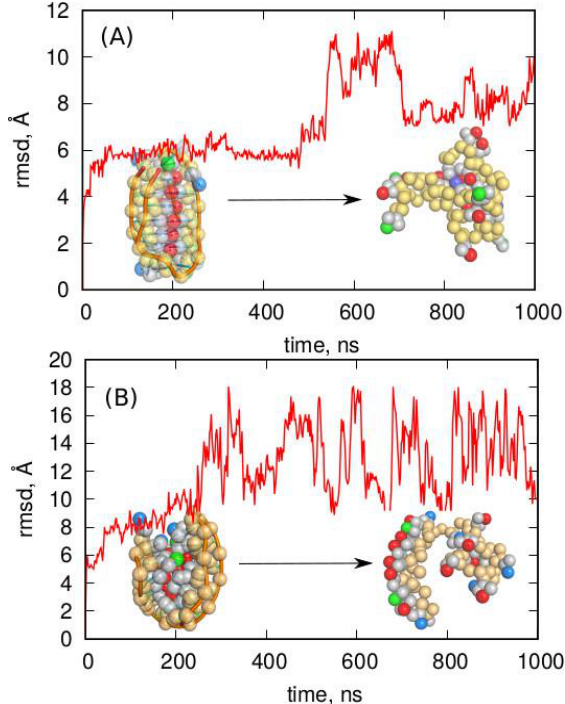
Figure 8. The rmsd determined for the i-motif ( A ) and G-quadruplex ( B ) in Martini coarse-grained representation. The snapshots on the left are the initial reference structures of both noncanonical DNA fragments, while the snapshots on the right are the corresponding structures at the end of the simulation.